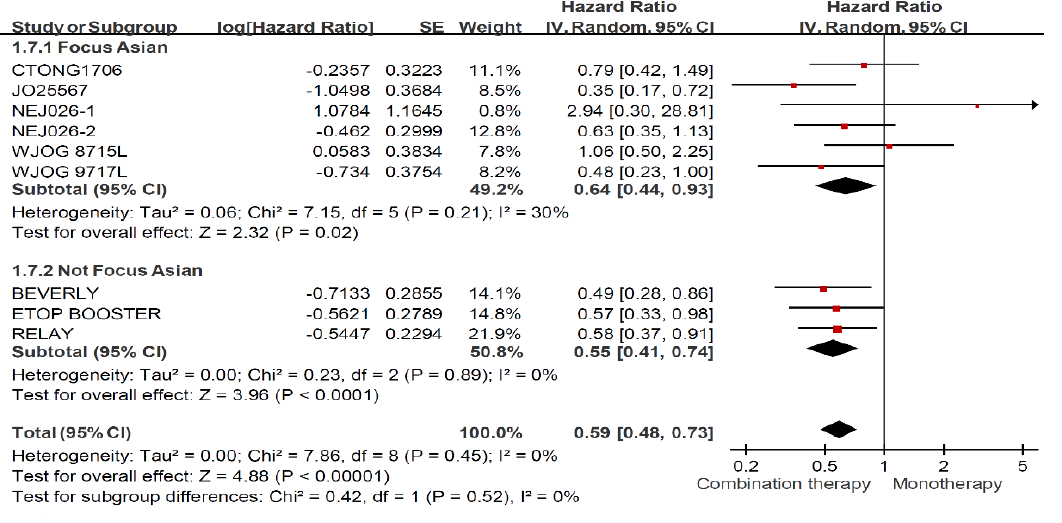
Figure 6. Forest plot and pooled hazard ratio for progression free survival (PFS) in the ever smoker subgroup (Stratified by ethnicity).